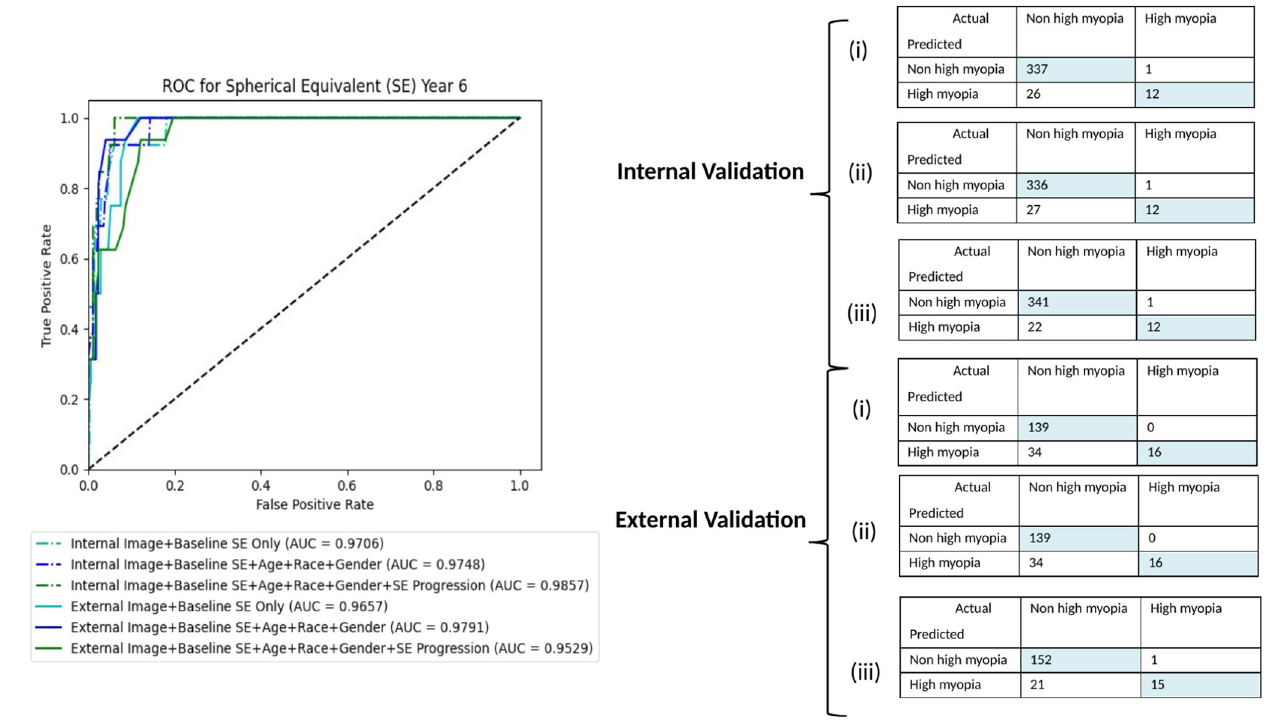
Fig. 3 Performance of mixed models. AUC and confusion matrixes for internal and external validation of mixed models — (i) Fundus photo + Baseline SE, (ii) Fundus photo + Baseline SE + Age + Race + Gender, and (iii) Fundus photo + Baseline SE + Age + Race + Gender + 1-year SE